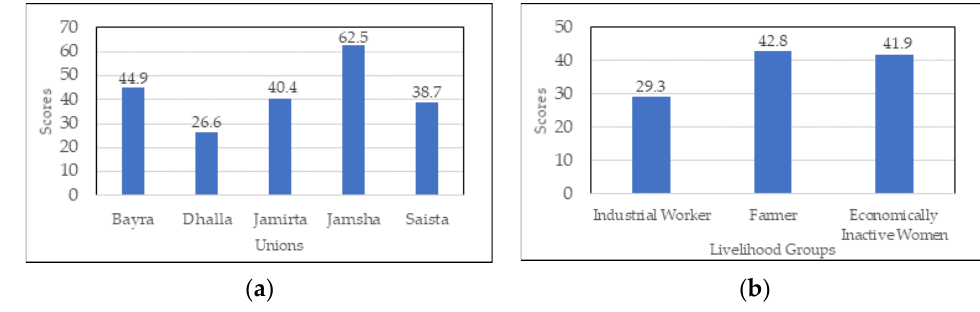
Figure 4. Score of resource component for: ( a ) 5 unions; and ( b ) livelihood groups.